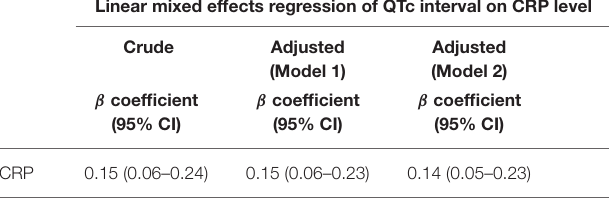
TABLE 2 | Crude and adjusted linear mixed effects regression of QTc interval on CRP level,demographics, ECG and clinical characteristics. Linear mixed effects regression of QTc interval on CRP